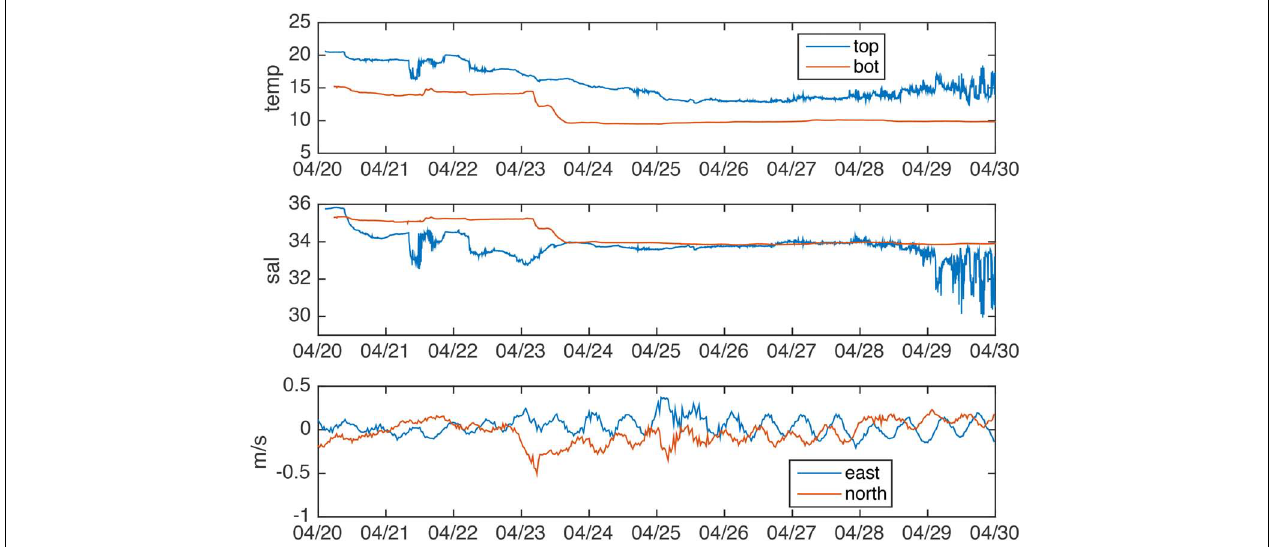
FIGURE 9 | Time series of temperature (upper panel) and salinity (middle panel) and depth-averaged velocity (bottom panel) from the B1 mooring in the PEACH array. Note the rapid drop in temperature and salinity near April 23, 2017, potentially indicative of the remnants of the Marine Heatwave reaching the continental shelf just north of Cape